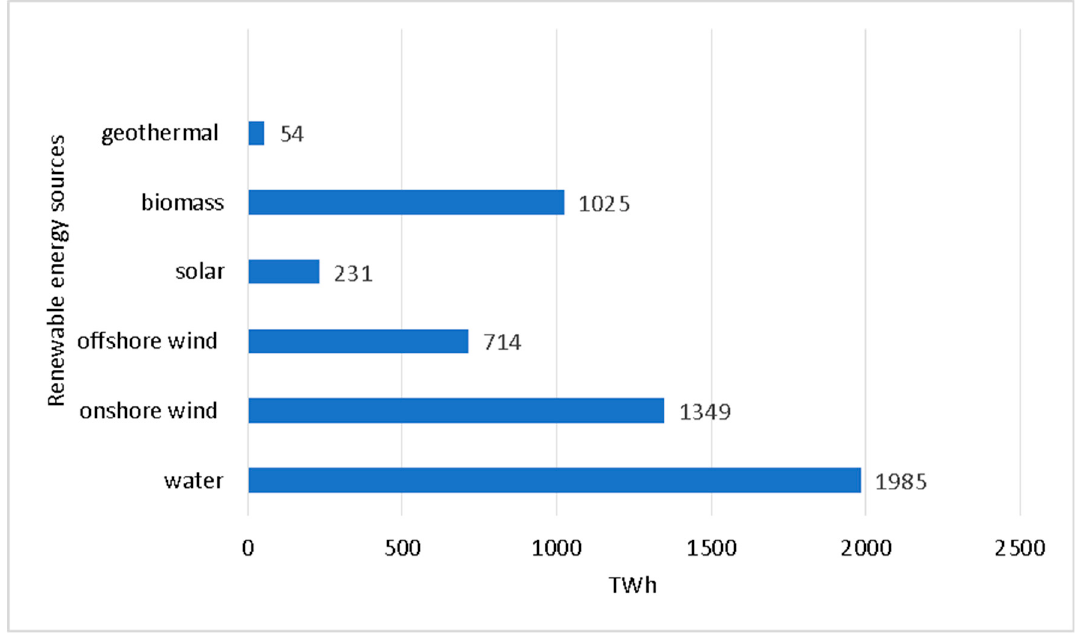
Figure 3. Total capacity in TWh in the European Union from renewable energy sources for the period 2005–2030—own study based on data [7,48].